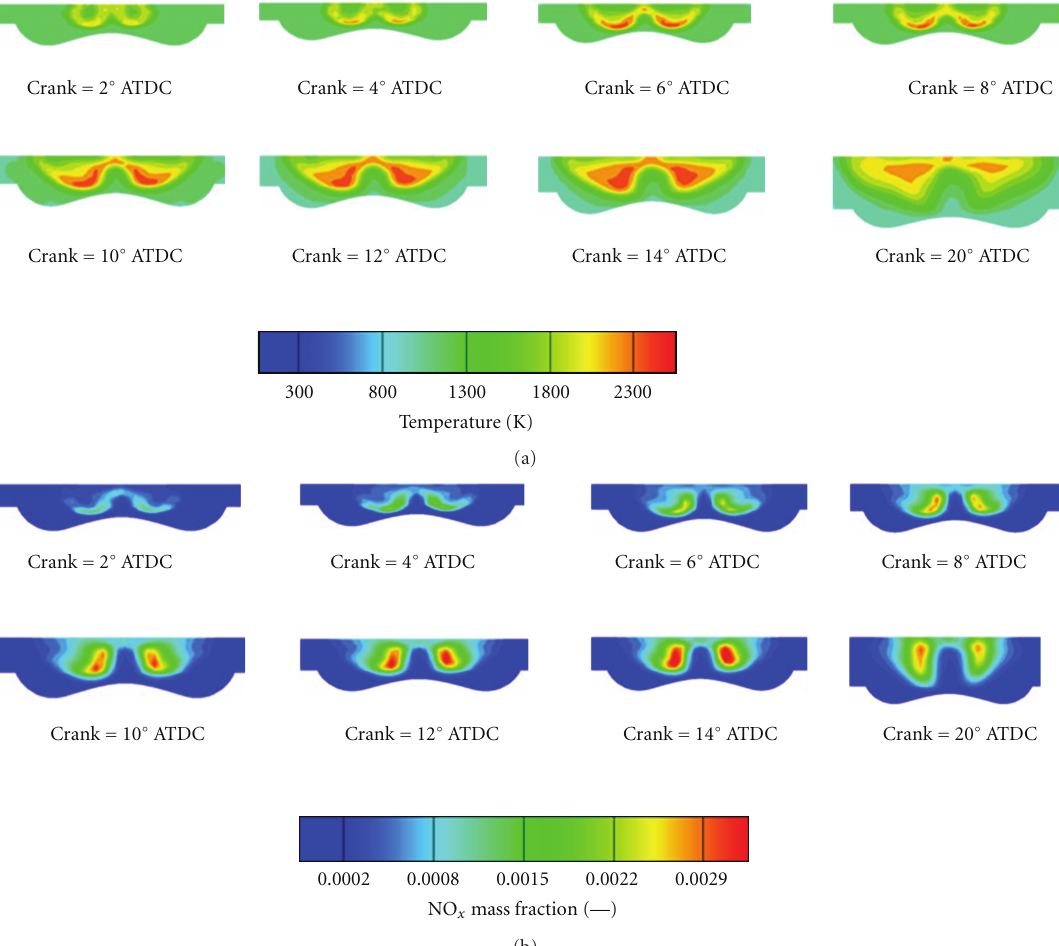
Figure 4: (a) Predicted in-cylinder temperature distribution and (b) predicted in-cylinder NO x mass fraction concentration.